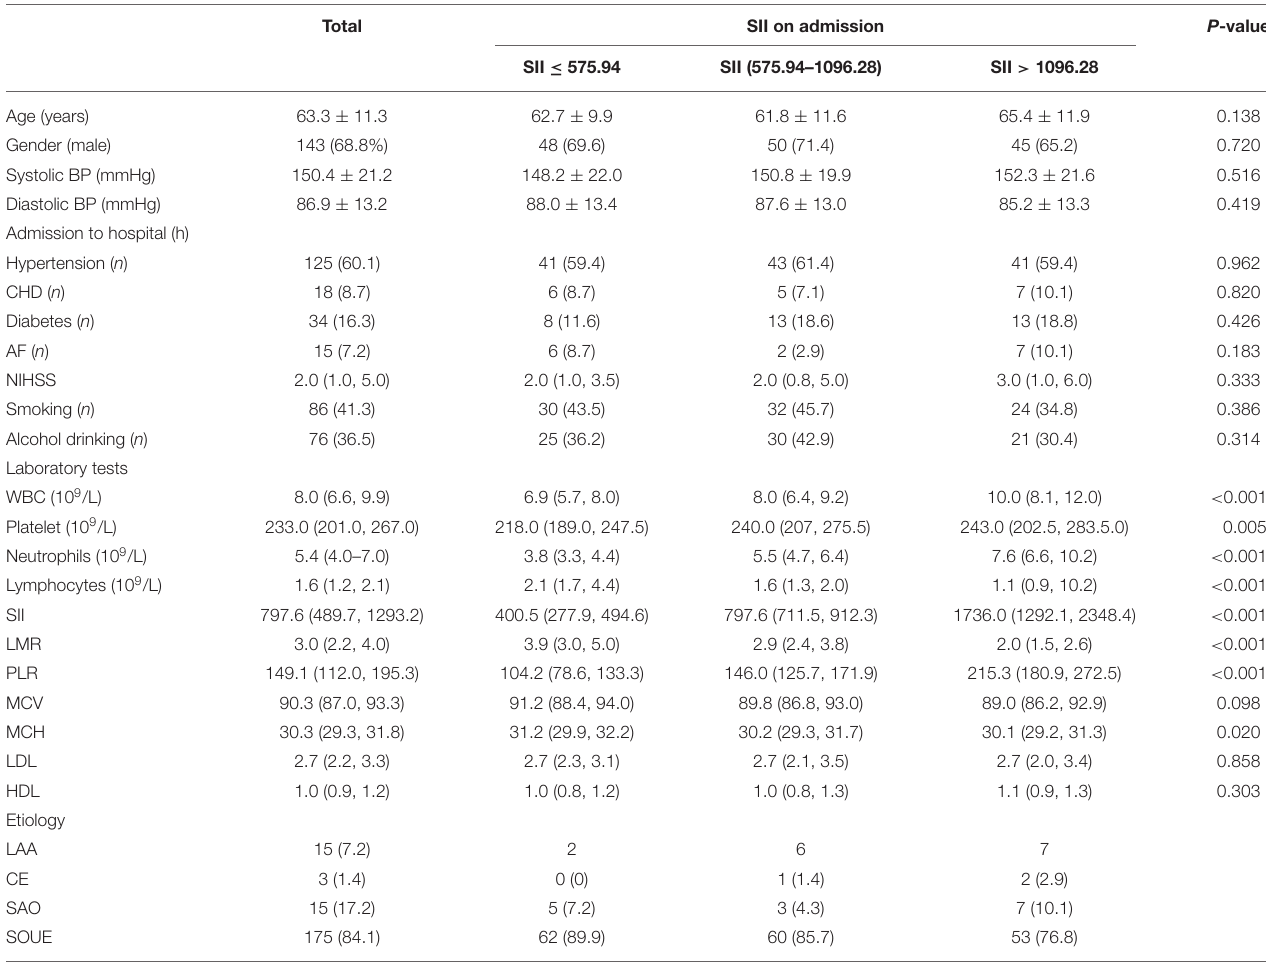
TABLE 1 | Baseline clinical characteristics of patients with AIS.